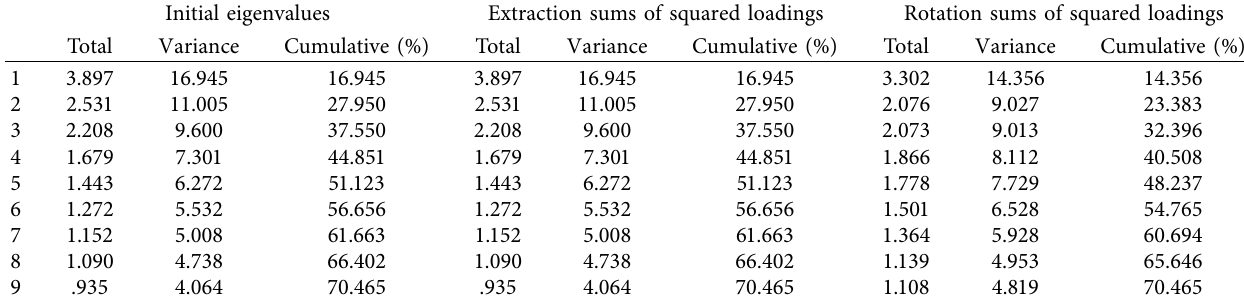
Table 5: Total variance explained.